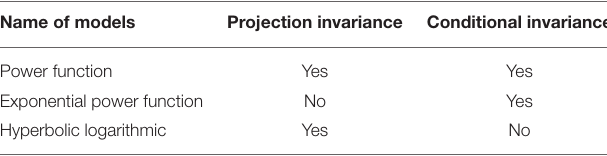
TABLE 10 | Correspondence between axioms and